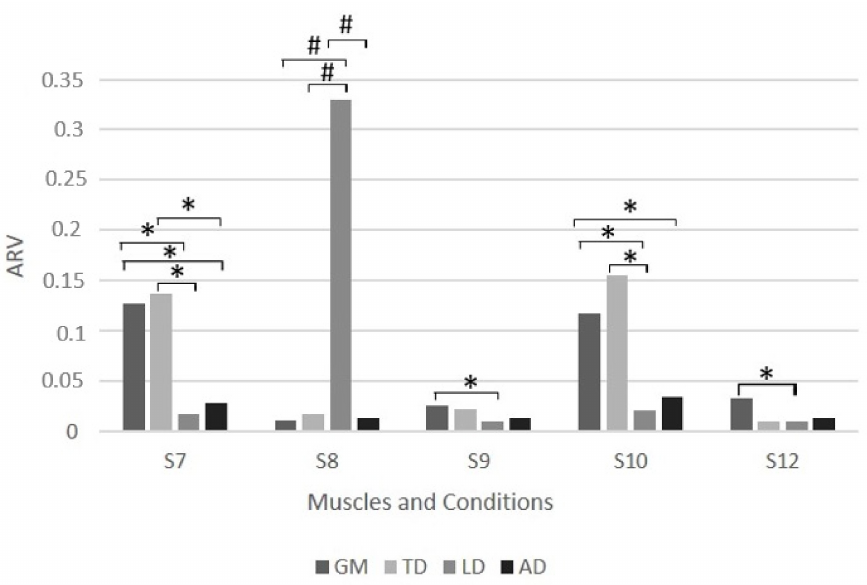
Figure 2. Differences according to ARV electromyographic activity (Tukey’s post-hoc test) in the different cycling conditions for a short bicycle frame. Differences between muscles for S7 (maximal intensity with high handlebars), S8 (150 watts of intensity with high handlebars), S9 (250 watts of intensity with high handlebars), S10 (maximal intensity with low handlebars), and S12 (250 watts of intensity with low handlebars) conditions for a short bicycle frame. TD—trapezius descending; LD—latissimus dorsi; GM—gluteus maximus; AD—anterior deltoid. * Significance for p < 0.05; # Significance for p <